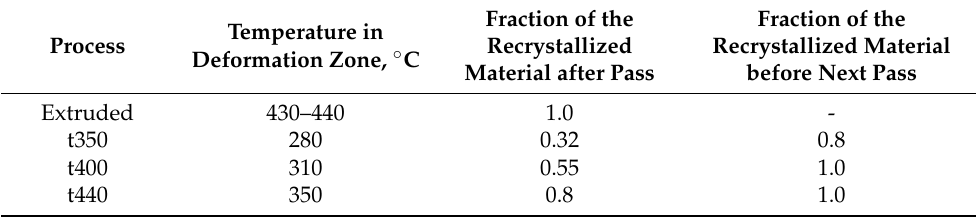
Table 2. The results of FEM